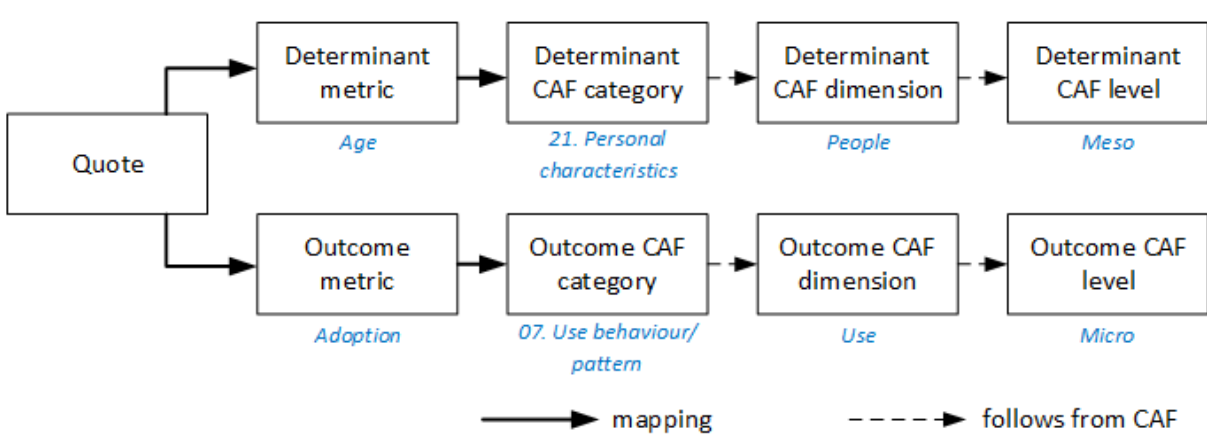
Figure 2. Example of how a quote is mapped to a determinant metric and outcome metric. CAF: Clinical Adoption